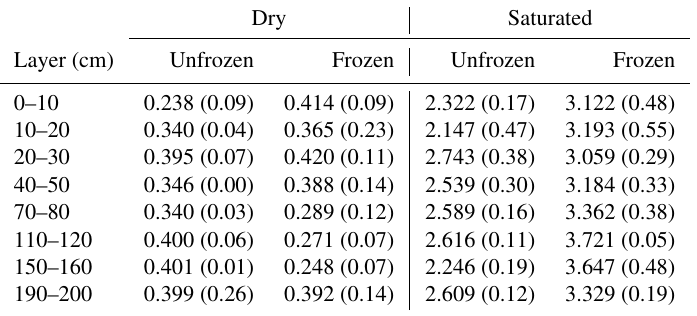
Table 3. The mean (standard deviation in brackets) of the measured frozen and unfrozen dry and saturated soil thermal conductivity (Wm − 1 K − 1 ) of different soil layers.